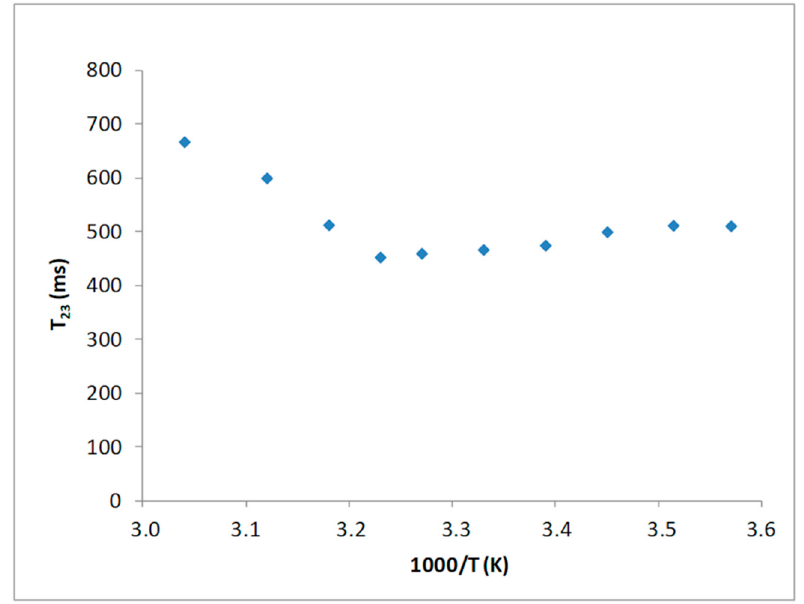
Figure 1. Temperature dependence of the T 23 values of the collagen sample.